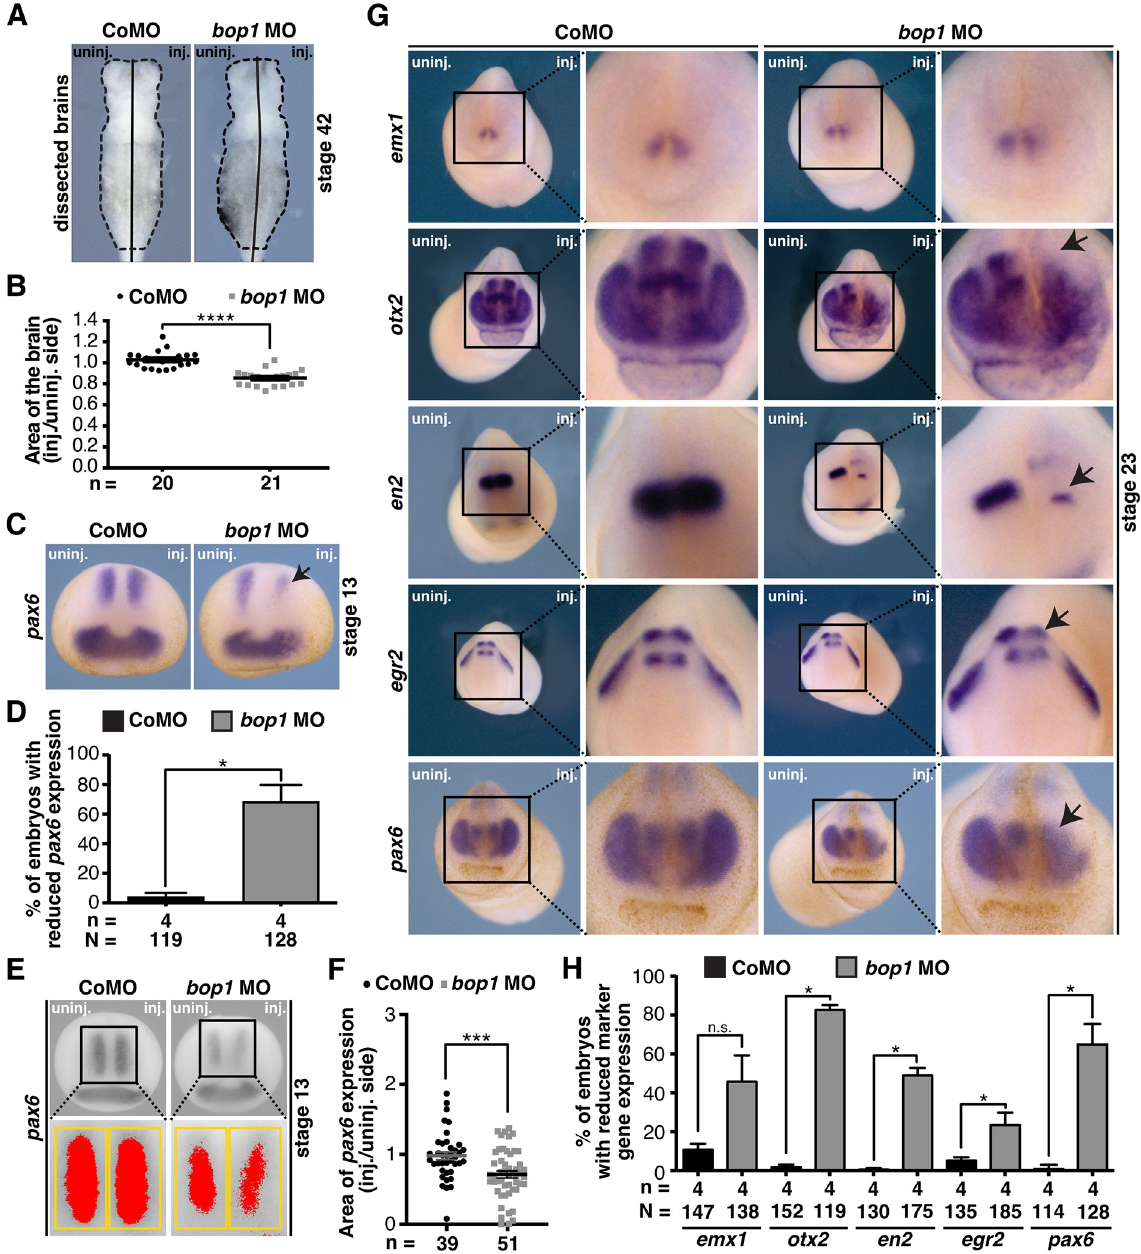
Fig 3. Bop1 is necessary for brain development in Xenopus laevis . A Sides of embryo brains injected with bop1 MO and Control MO and uninjected sides were compared (ventral view). B Statistical evaluation showed that bop1 knockdown led to a significantly smaller area of the brain. C Xenopus embryos were injected with either 20 ng bop1 MO or Control MO, and pax6 expression in the anterior neural tube was investigated at stage 13 (black arrow indicates location of reduced gene expression). pax6 expression was decreased upon bop1 knockdown. D Statistical evaluation of data given in C. E Area of pax6 expression was investigated at stage 13 embryos via ImageJ. Expression domain was photographed and injected side was compared to uninjected side. Yellow boxes indicate area in which pax6 expression (red area) was measured. F Statistical analysis confirmed reduction of pax6 expression upon bop1 knockdown. G Brain-specific marker genes were analyzed in stage 23 embryos. Embryos were injected with 20 ng bop1 MO or Control MO. Black arrows indicate location of reduced gene expression. H As shown by statistical evaluation, upon bop1 knockdown expression of otx2 , en2 , egr2 , and pax6 was significantly decreased. Control MO- injected embryos showed normal gene expression. Abbreviations: bop1 MO, block of proliferation 1 morpholino oligonucleotide; CoMO, Control MO; inj., injected side; n, number of independent experiments; N, number of injected and analyzed embryos; n.s., non-significant; uninj., uninjected side. Error bars indicate standard error of the means; � , p � 0.05; ��� , p � 0.001; ���� , p � 0.0001.